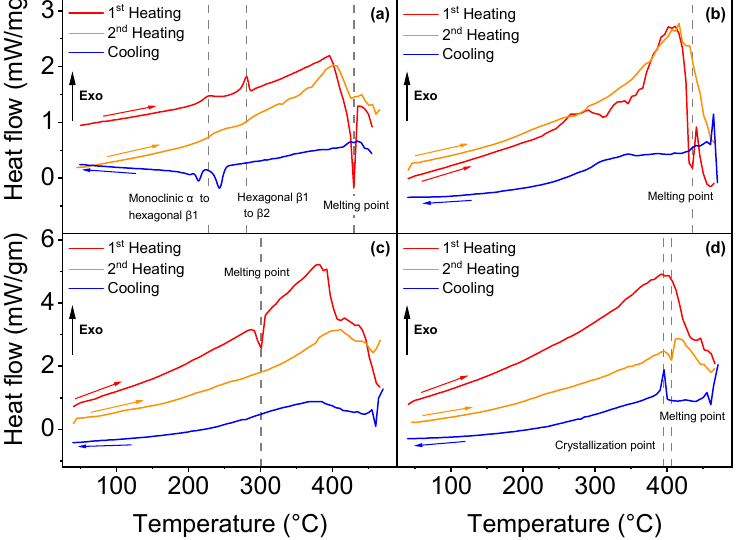
Figure 2. DSC analysis curves for each parylene type: ( a – d ) illustrate the first and second heating cycles and the cooling curves, respectively, for parylene N, VT4, C and AF4